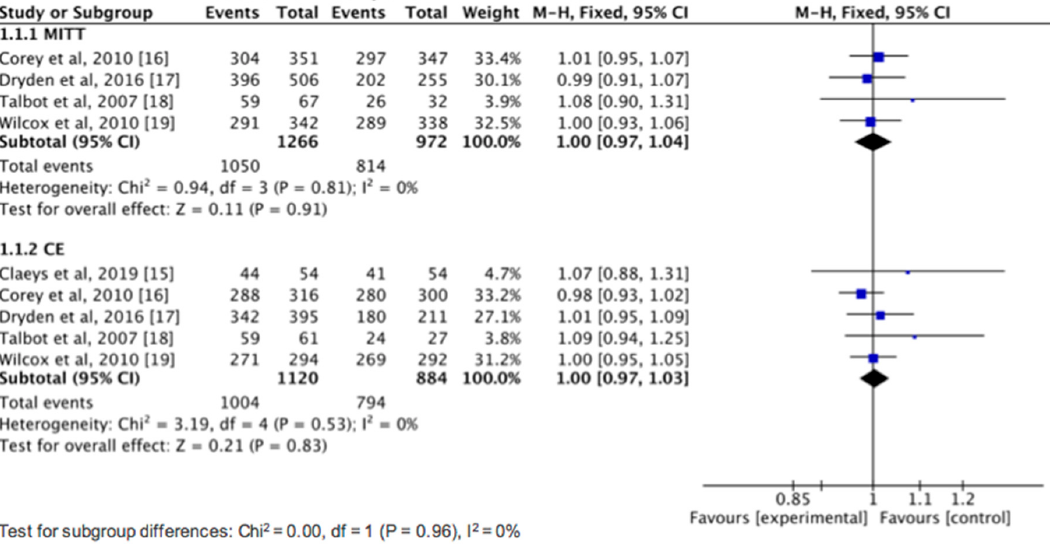
Figure 3. Overall clinical cure rates for ceftaroline and comparators in the treatment of complicated skin and skin structure infections. MITT: modified intention-to-treat; CE: clinically evaluable.